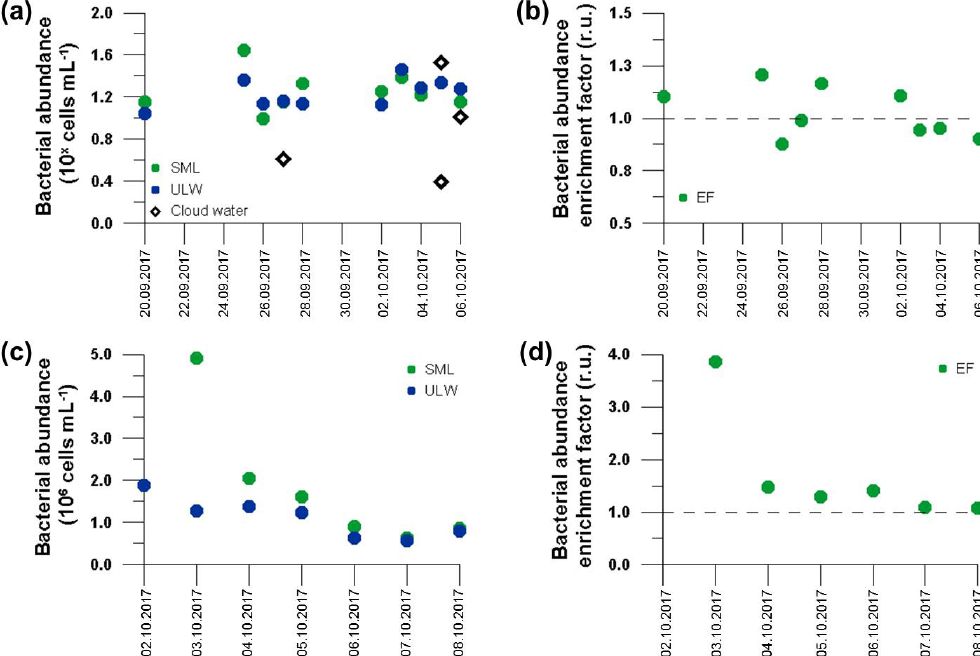
Figure 21. Bacterial abundance of SML and ULW from (a) field and (c) tank water samples as well as from cloud water samples (diamonds, a ) taken during the campaign. Additionally, enrichment factors (i.e., SML versus ULW) are presented (b, d) . In panel (a) , please note the